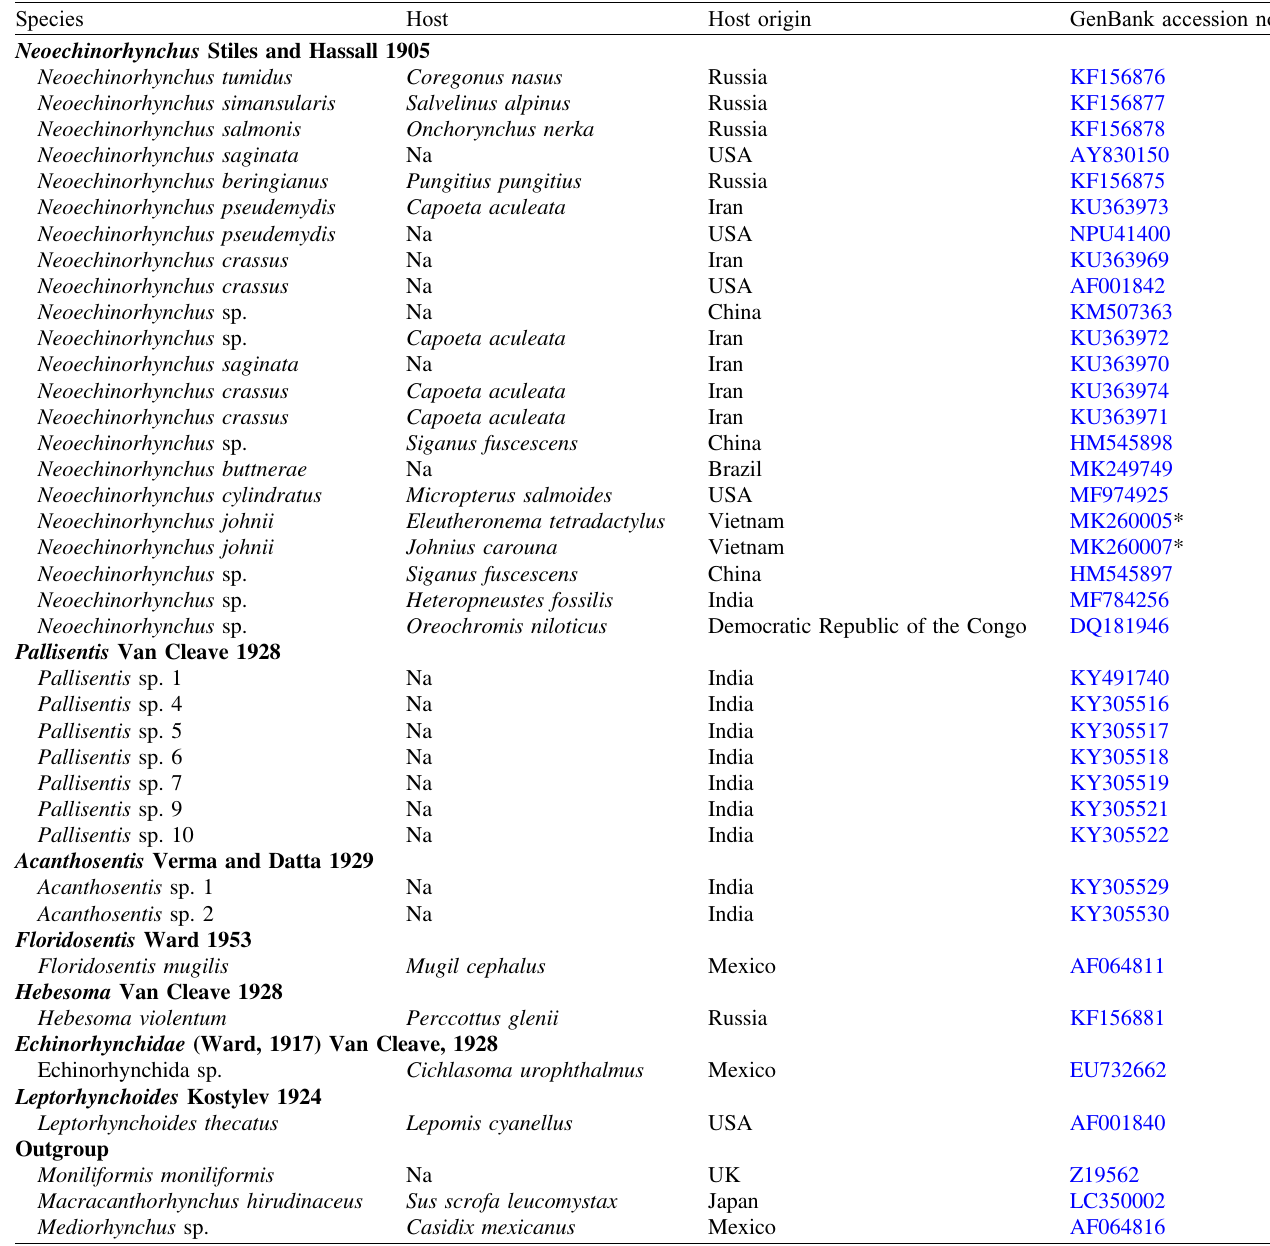
Table 5. Acanthocephala species, origin and GenBank accession numbers used for phylogenetic analysis based on the 18S region. Sequences marked with an asterisk were obtained in this study. Na = not